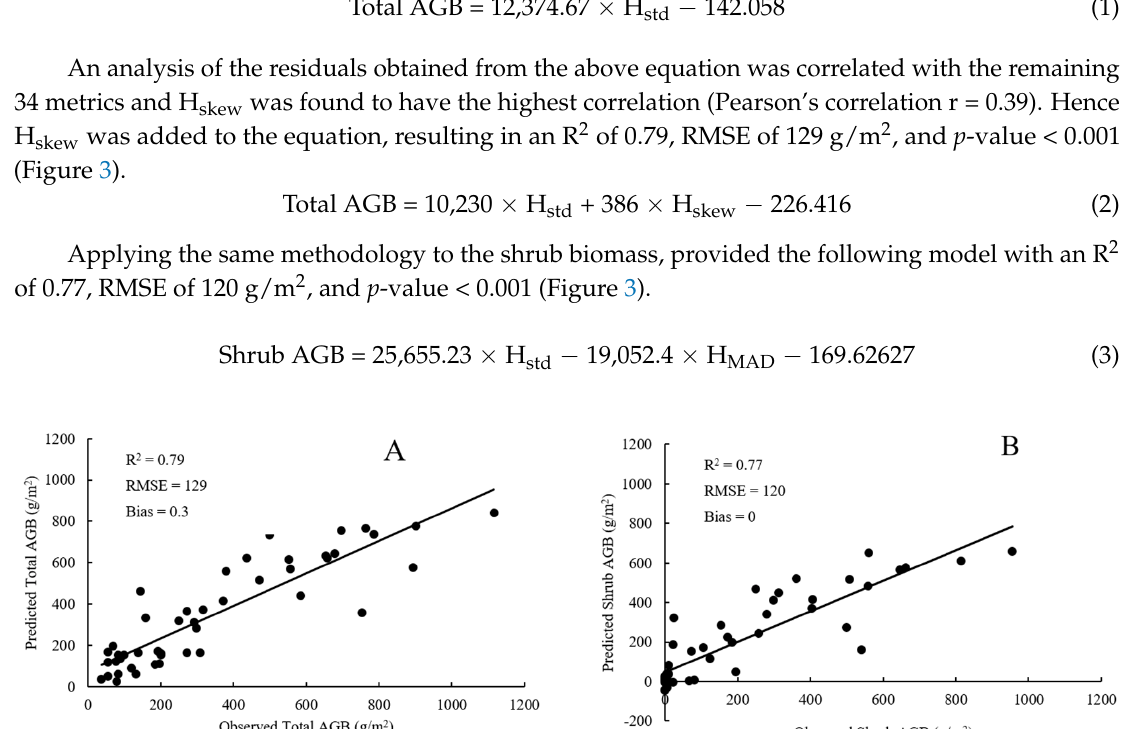
Figure 3. Scatterplots between the observed AGB (field-measured biomass) and the AGB with Equations (2) and (3) for total ( A ) and shrub ( B ) biomass.